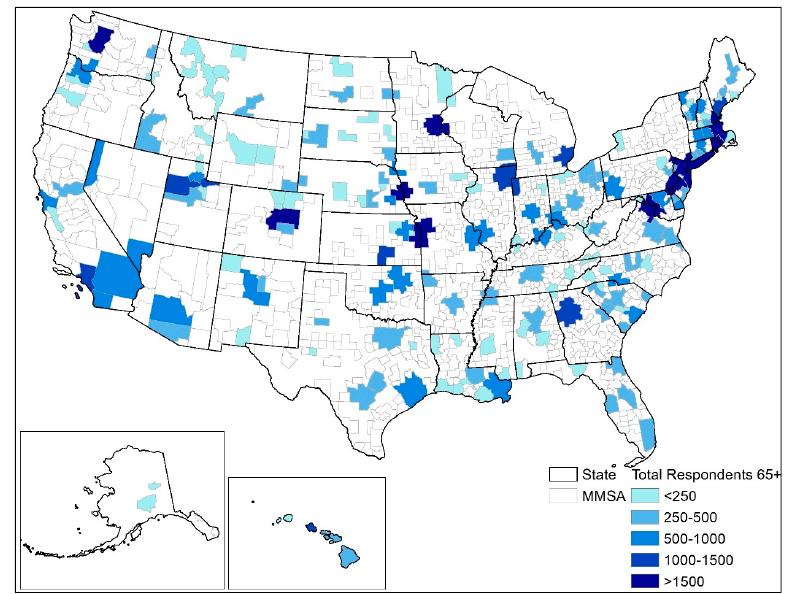
Figure 1. The study area, which contains 185 metropolitan and micropolitan statistical areas (MMSAs) reported in the 2011 Selected Metropolitan/Micropolitan Area Risk Trends (SMART) dataset. The color scheme indicates the number of respondents aged 65 years and above by MMSA. Those MMSAs without color were not reported in the SMART data for having less than 500